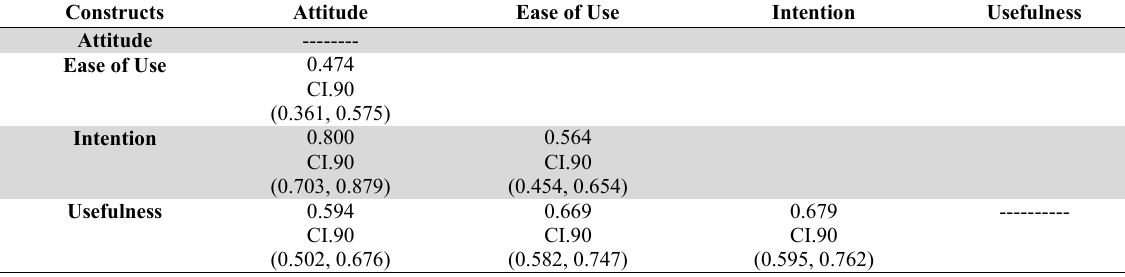
Heterotrait-Monotrait Ratio (HTMT) Constructs Attitude Ease of Use Intention Usefulness